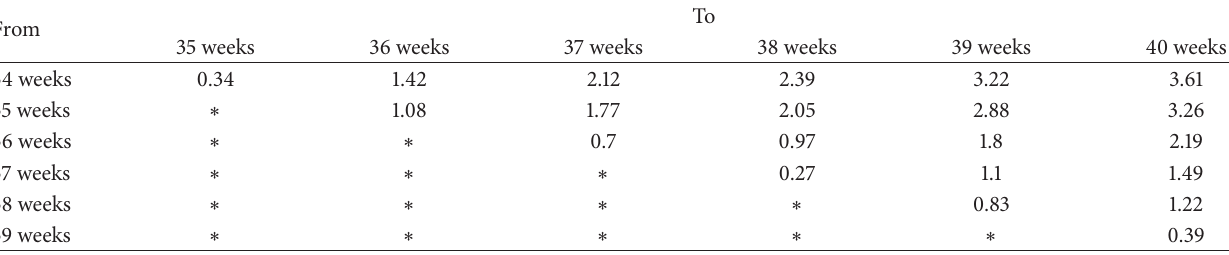
Table 2: Mean change in AFI (cm) values at different intervals.